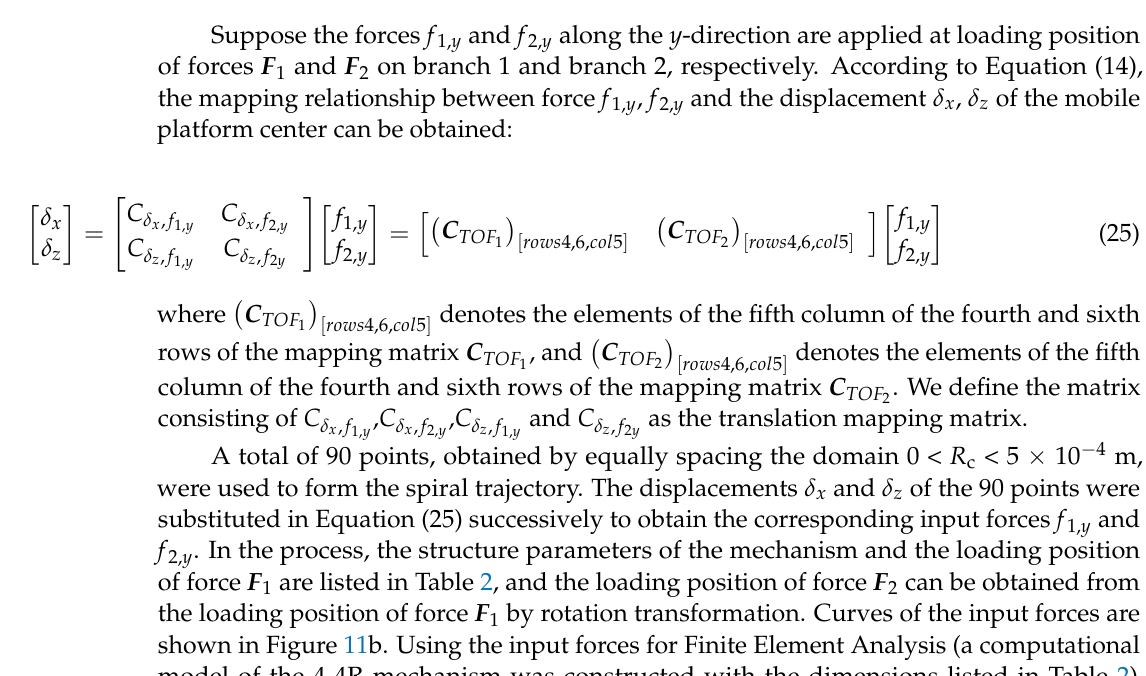
Figure 11. ( a ) Analytical spiral trajectory; ( b ) curves of the input forces f 1, y , f 2, y